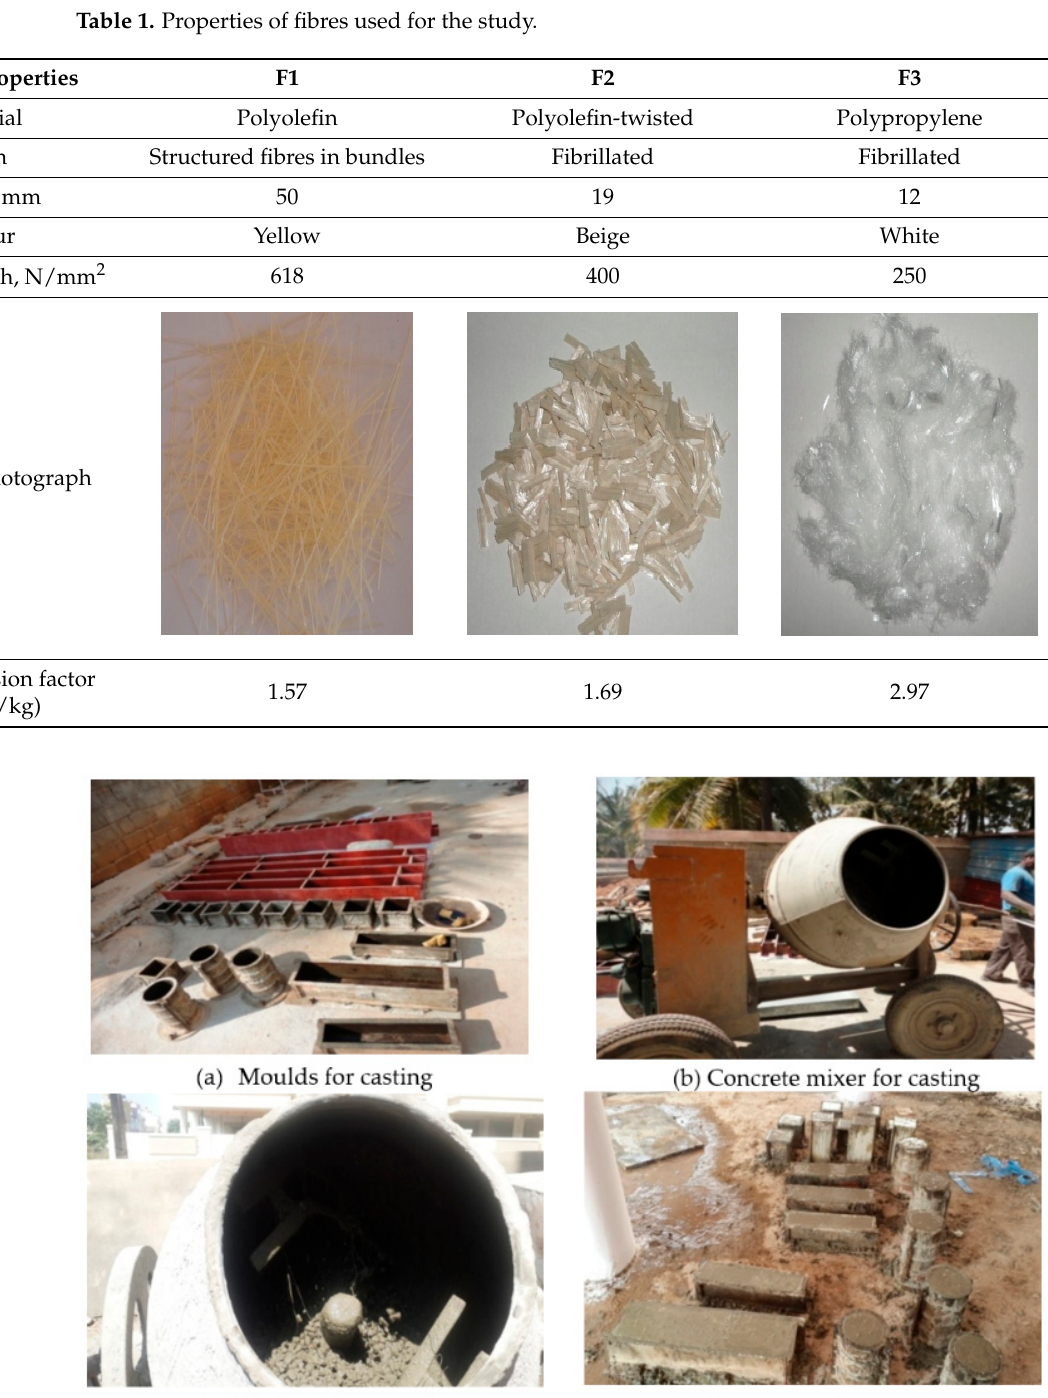
Table 2. Mix design details of 1 m 3 of concrete . Water